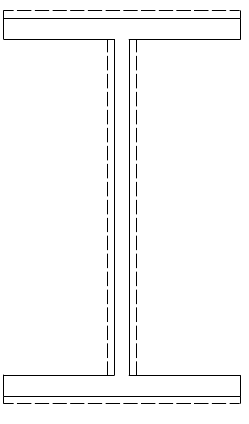
Figure 15. Simplified cross ‐ section of corroded H ‐ shaped steel beams. According to Standard for design of steel structures (GB 50017-2017) [30], the yield calculated using Equations (8) and (9),